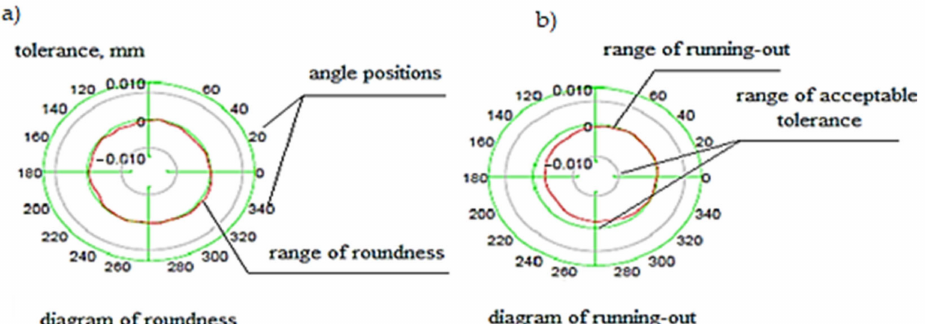
Figure 8. Diagram of defects of rolls made of HSS high-speed steel: ( a ) out of roundness, ( b ) run-out. Source: own, based on [38].